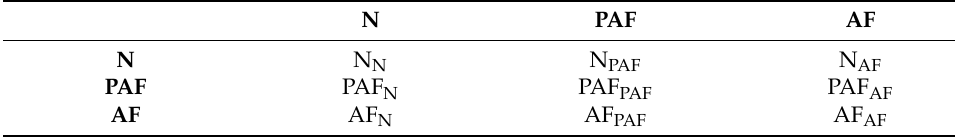
Table 10. Confusion matrix-related